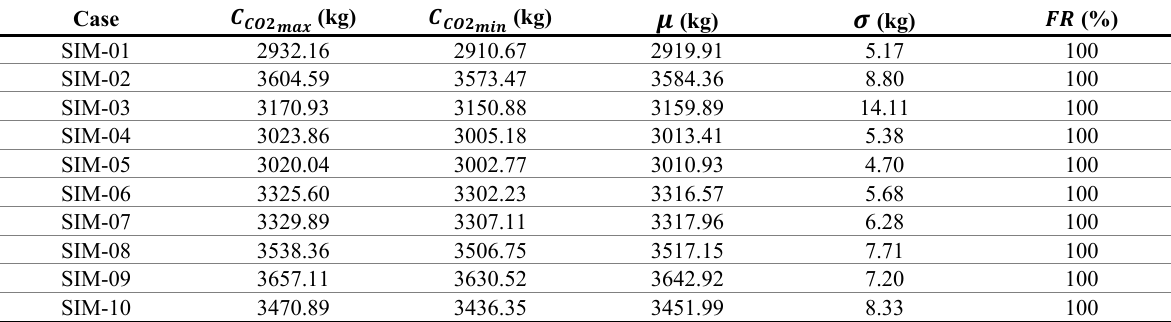
Table 11. Range of design variables for the optimization problem.